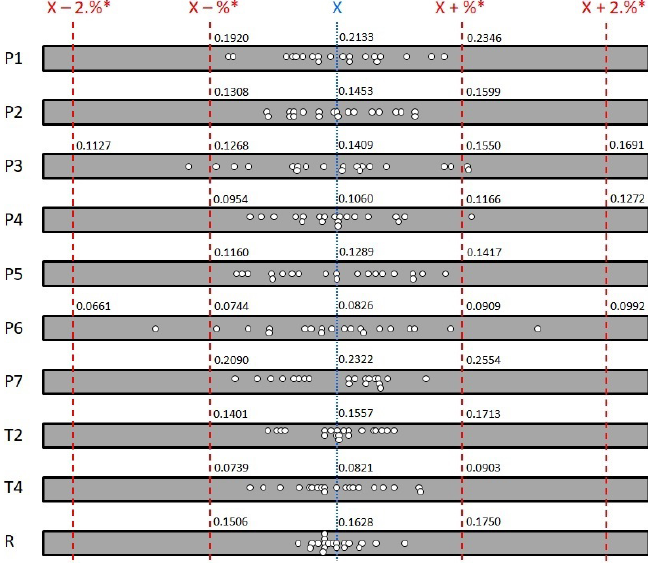
FIGURE 1 - Individual weight distribution of the 20 units of tested capsules and tablets. The dotted line delimits the mean weight ( X ̅ ) and the dashed lines indicate the maximum ( X ̅ + %) and minimum ( X ̅ – %) variation limits, as well as double the maximum variation limit ( X ̅ + 2. %) and minimum ( X ̅ – 2. %), though the latter should be observed only when there are up to 2 units outside the first